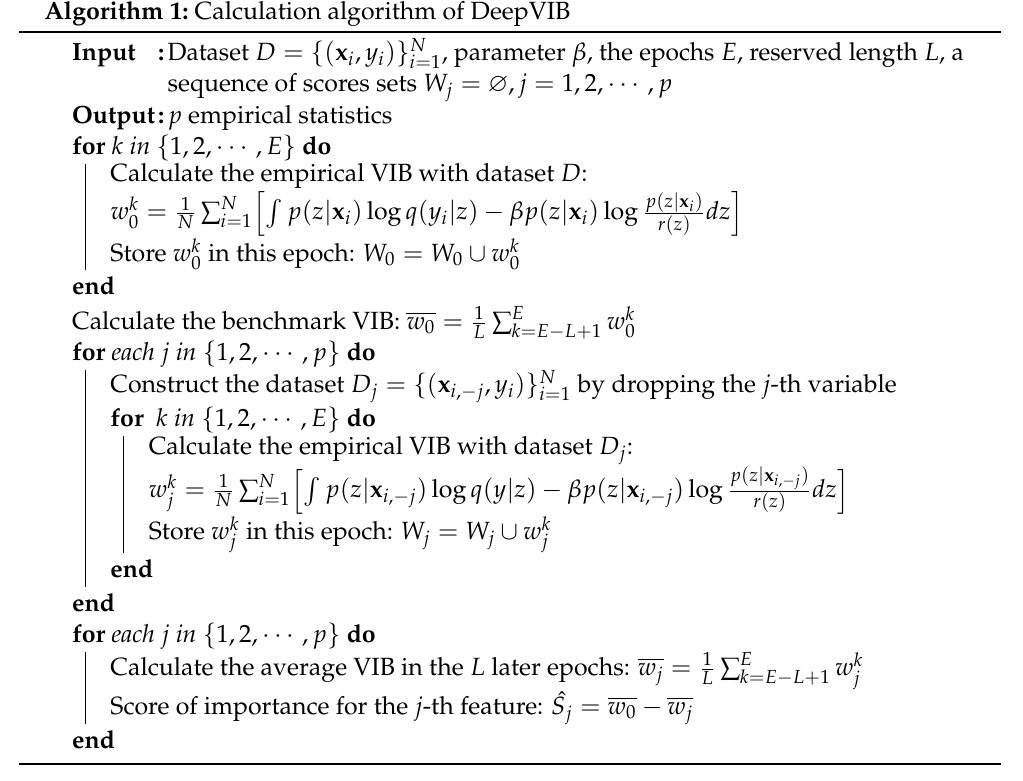
Algorithm 1: Calculation algorithm of